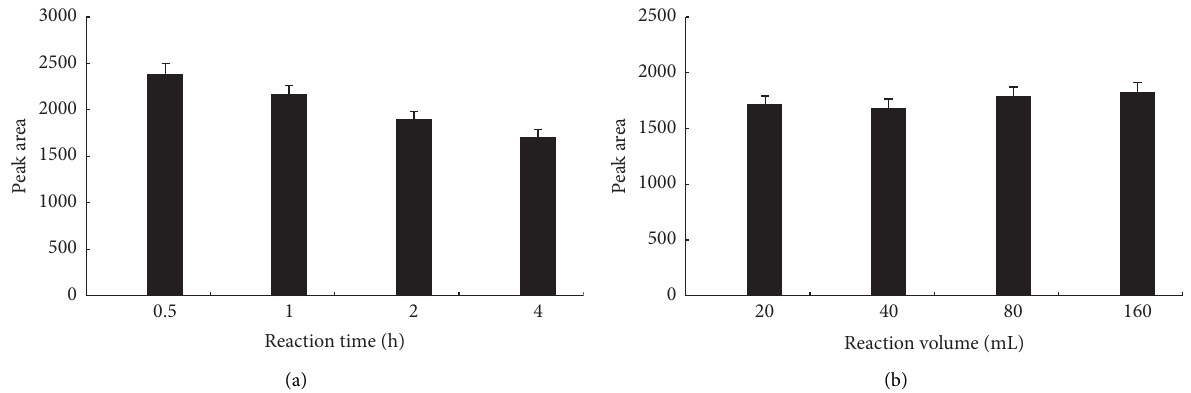
Figure 3: Effects of reaction time and volume on luteolin-metal complex formation. (a) Luteolin (0.1mmol) mixed with 0.02 mmol anhydrous calcium chloride, anhydrous zinc chloride, magnesium chloride hexahydrate, iron chloride hexahydrate, or copper chloride dihydrate was allowed to proceed for 0.5, 1, 2, or 4h under heat backflow at a temperature of 90 ° C. (b) The reaction in (a) was carried out in 20, 40, 80, or 160mL distilled water at 90 for 2h. After free ion salts were removed, the reactants were analyzed by HPLC as described in methods. The experiment was performed at least three times independently in triplicate.